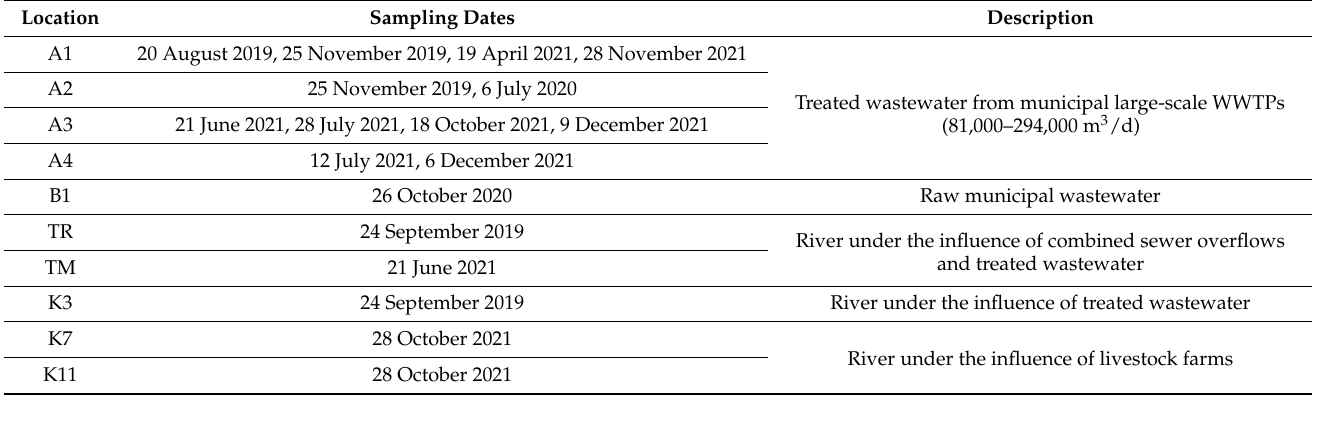
Table 5. Sample origins for the collection of CRE.